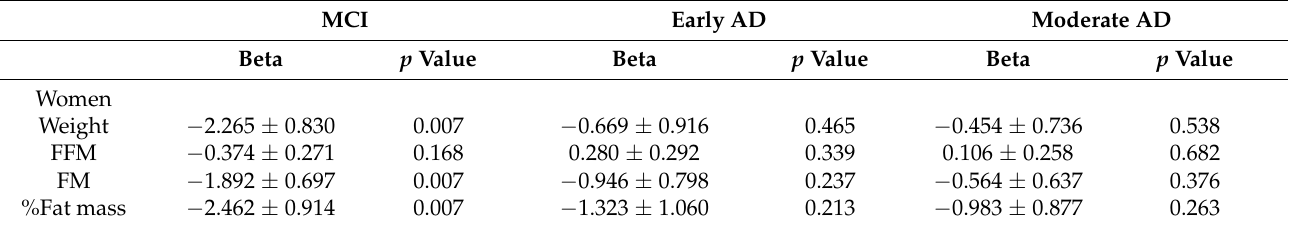
Table 3. Impacts of APOE- ε 4 on measures of body composition in each stage of cognitive